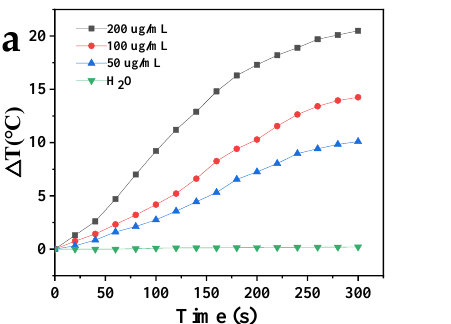
Figure 8. HCT-116 cell viability rate after 24 h of treatment with MPDA-DOX@FU-SS, DOX, and MPDA-DOX@FU-SS+NIR (n = 3; ** p < 0.01, * 0.05 > p > 0.01, + p > 0.05).